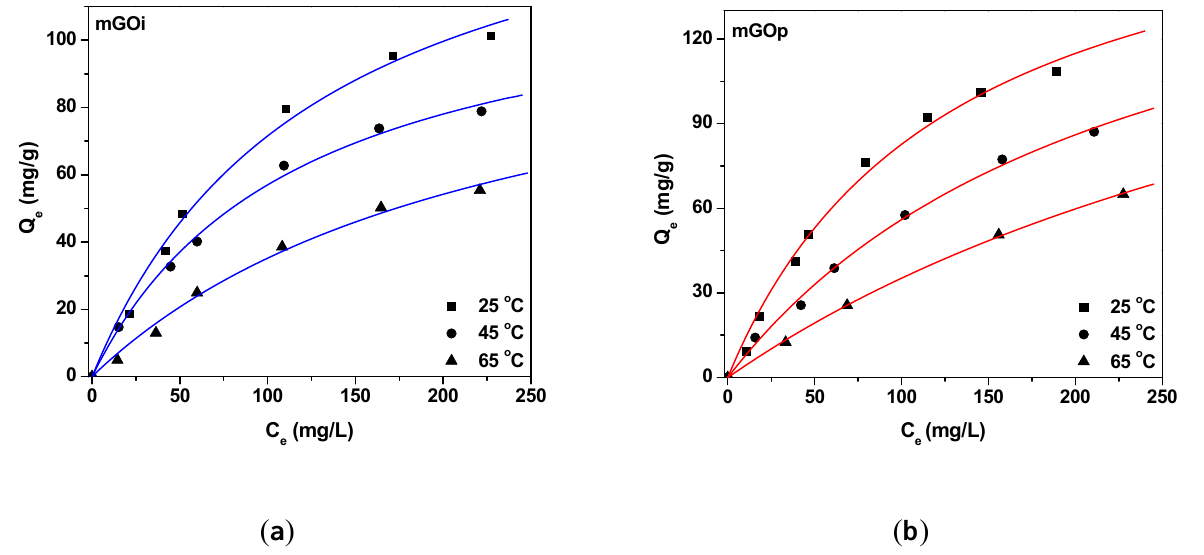
Figure 9. Isotherms of the adsorption of RB5 onto ( a ) mGOi and ( b )